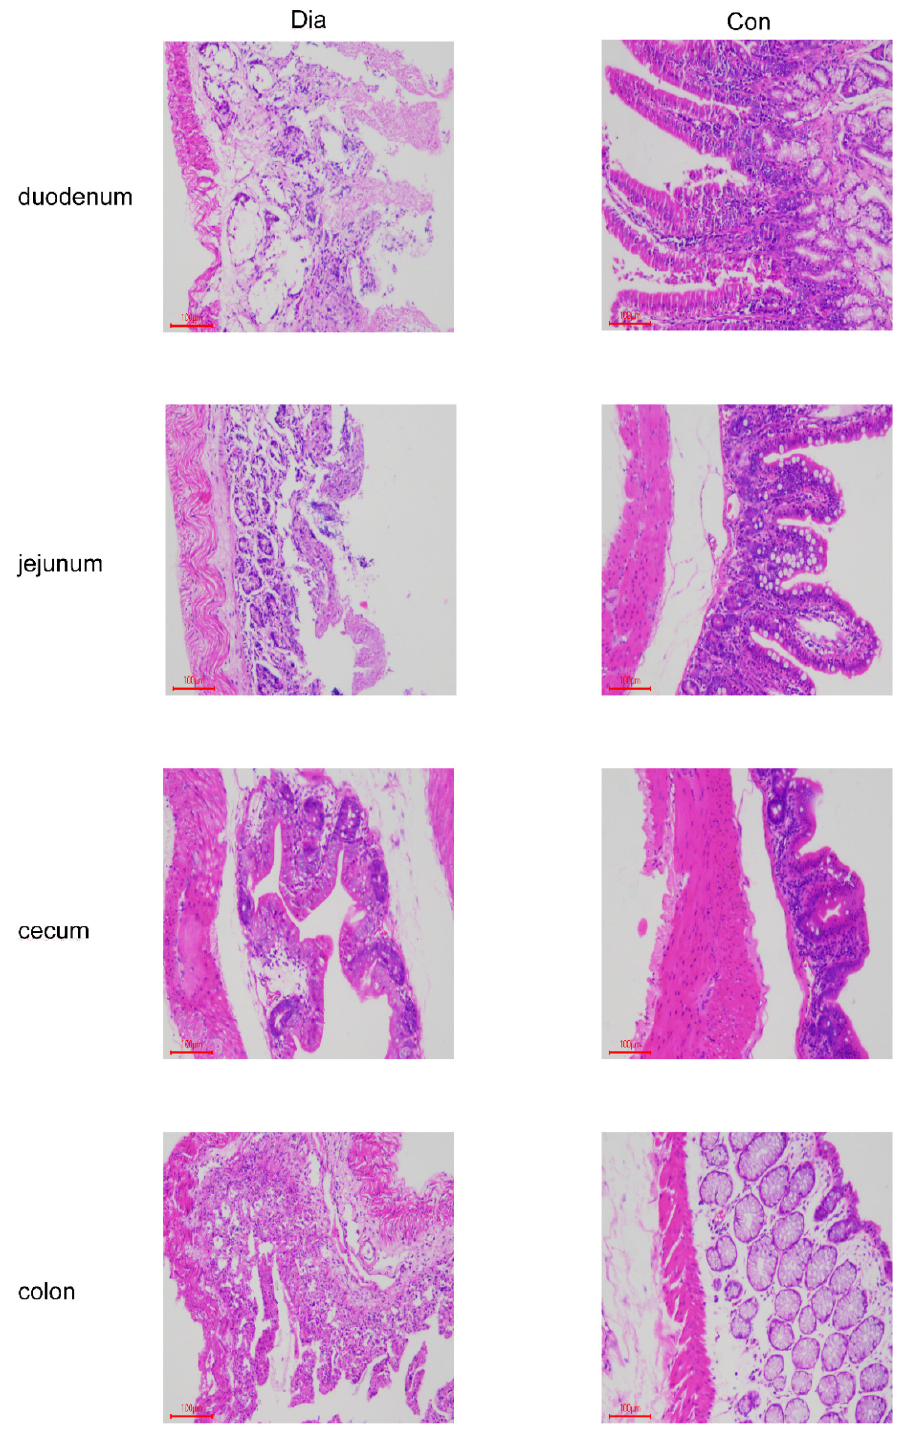
Figure 2. Hematoxylin and eosin stained duodenal, jejunum, cecum, and colon tissue samples from Dia ( n = 6) and Con ( n = 6) Hyplus rabbits caused by stopping the use of antibiotic diet. Con, control group; Dia, diarrhea group.